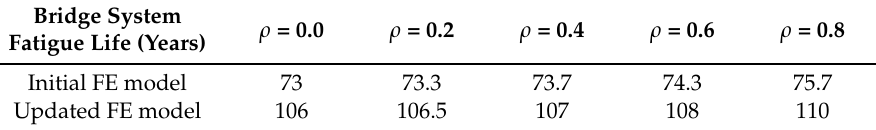
Table 5. Fatigue life of the bridge system for various correlation